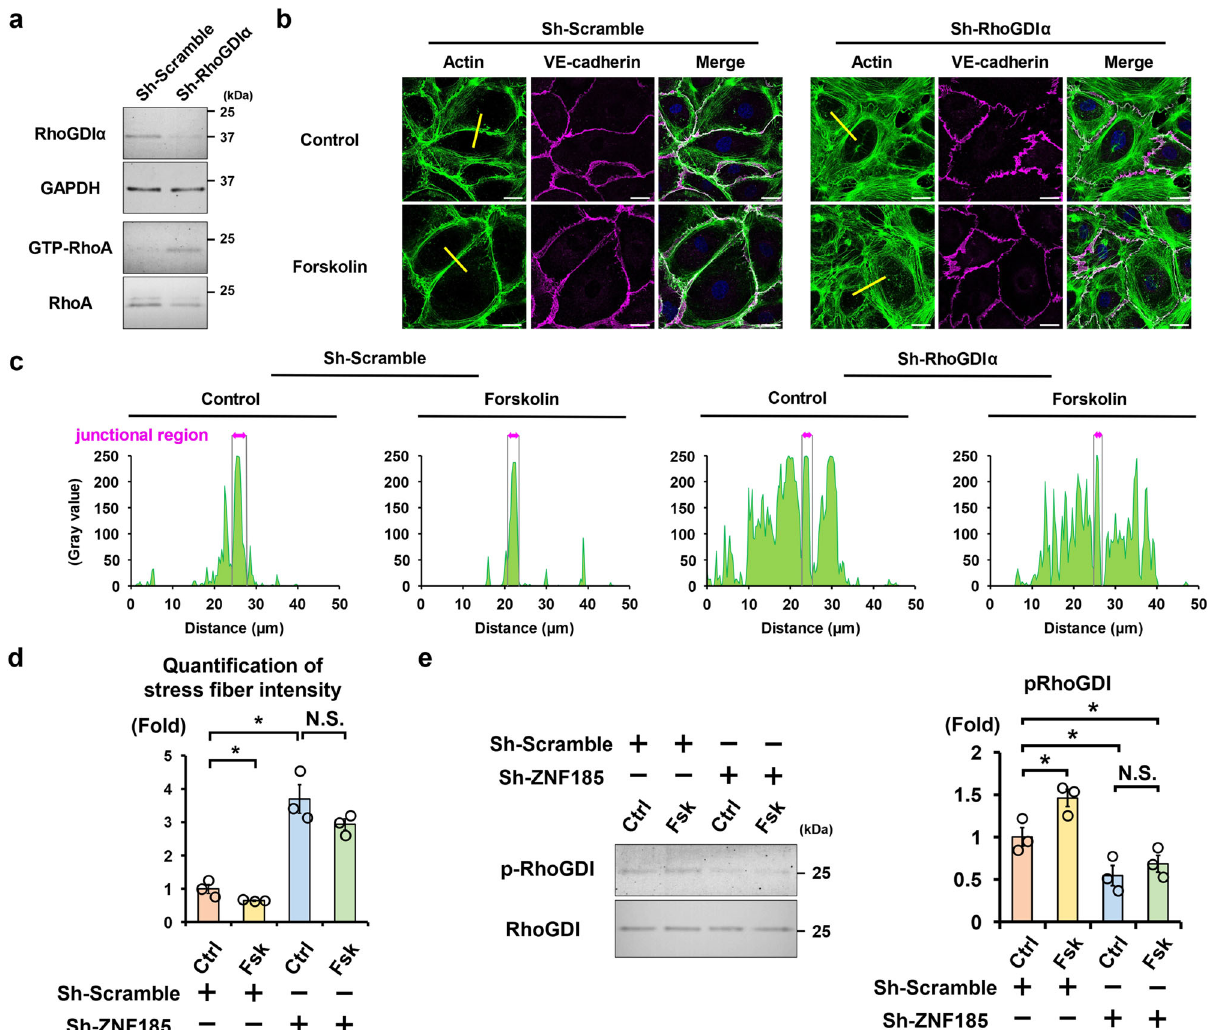
Fig. 5 ZNF185 is essential for PKA-induced phosphorylation of RhoGDI α . a RhoGDI α knockdown induces RhoA activation. RhoA activity in HUVECs was measured using a rhotekin pull-down assay. Representative images are shown ( n = 3). b – d . RhoGDI α knockdown induces stress fi ber formation in a con fl uent HUVECs monolayer. b Immuno fl uorescence staining of actin (green) and VE-cadherin (magenta). Representative images are shown ( n = 3). Scale bars, 25 µ m. c Intensity of stress fi bers at the yellow lines in Fig. 5b was quanti fi ed. d The bar graph shows total amount of stress fi ber intensity in Fig. 5c. Two-sided Student ’ s t test, * p < 0.05 ( n = 3). e ZNF185 knockdown suppressed RhoGDI α phosphorylation. Western blots and densitometry analysis of phospho-RhoGDI. Representative blots are shown. Two-sided Student ’ s t test, * p < 0.05 ( n = 3). Data are presented as the mean ± standard error. Ctrl control, Fsk